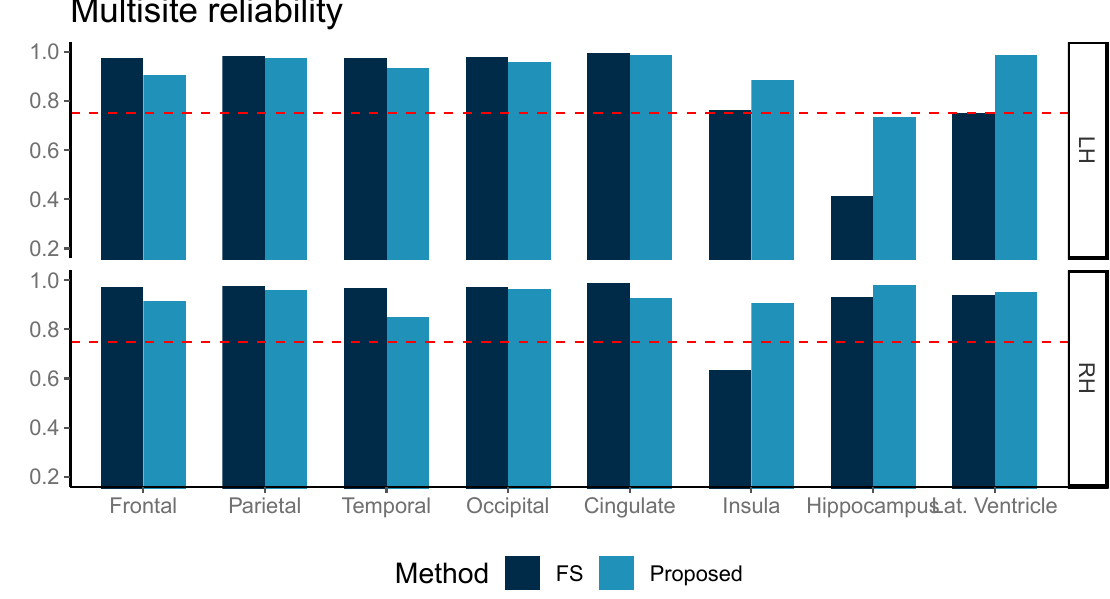
Figure 4. Multicenter reliability, intraclass correlation (ICC, two-way, agreement) was compared between two methods, FreeSurfer (FS) and the proposed method (Proposed, light blue). ICC was computed for two repeated measurements and the reference line at ICC = 0.75 is marked with the dotted red line.